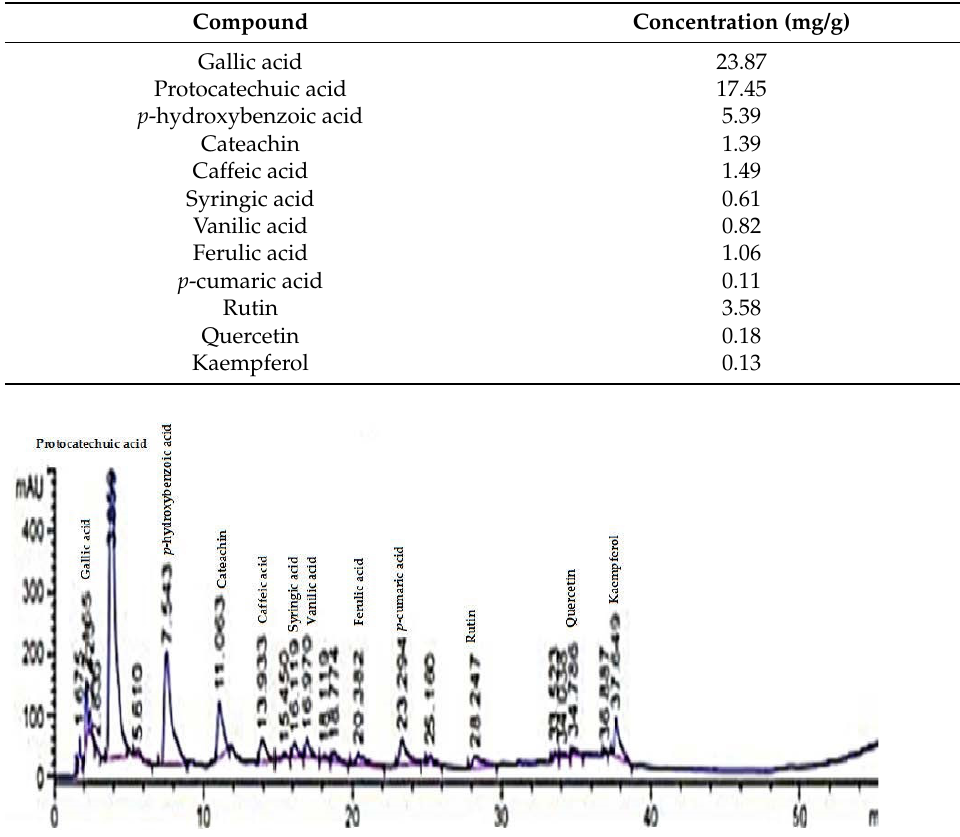
Table 3. Phenolic content in grape seed powder extract.